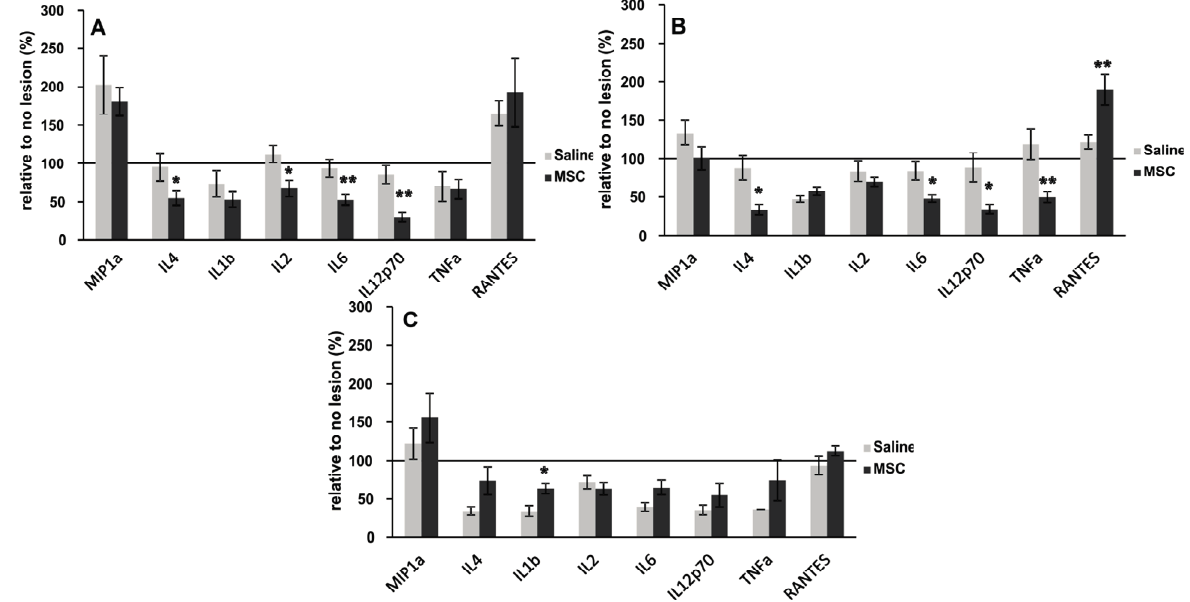
Figure 7. Levels of proinflammatory cytokines 10, 14 and 28 days after SCI in MSC- and control-treated rats. ( A ) Ten days after SCI, a significant decrease in the levels of IL4, IL2, IL6 and IL12p70 was observed; ( B ) Fourteen days after SCI, the decrease of IL4, IL6, IL12p70 and TNF- α continued; ( C ) Twenty eight days after SCI, the levels of cytokines did not reduce; rather, they were approximately equal to that of controls, with the exception of IL1b, where an increase in cytokine levels was seen. Statistical significance was achieved at * p < 0.05, ** p <